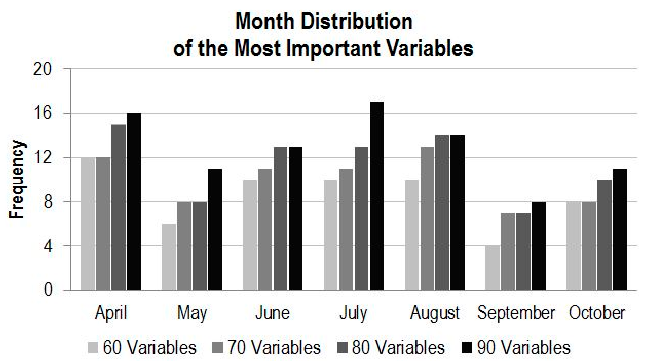
Figure 7. Month frequency with the number of the most importance variables.